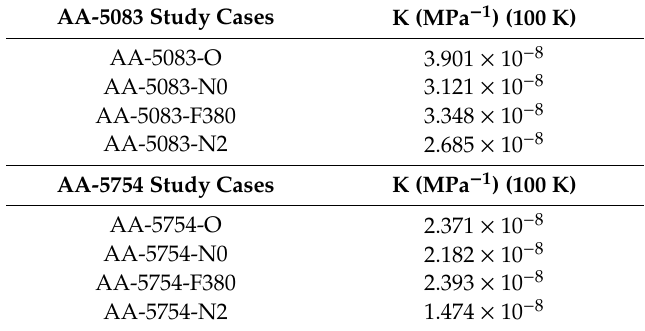
Table 3. Wear in terms of volume loss (mm 3 ) for FEM simulations and experimental tests at 100,000 revolutions.